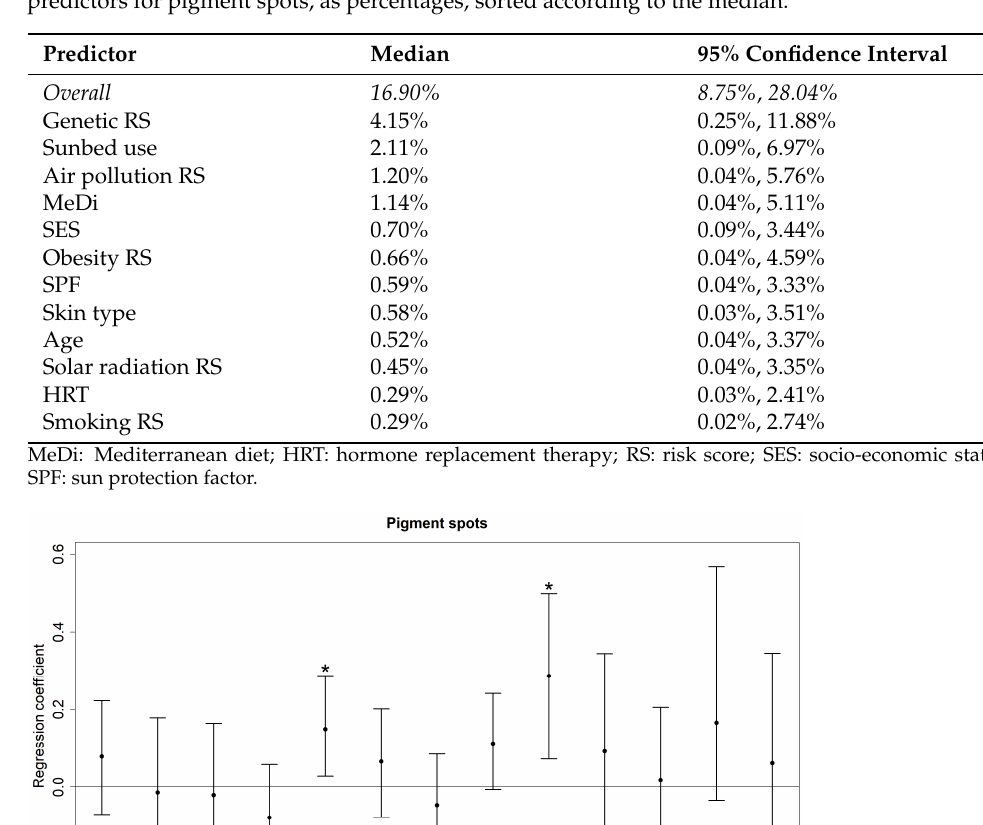
Table 2. Relative Contributions (bootstrap median and 95% percentile confidence interval) of the predictors for pigment spots, as percentages, sorted according to the median.